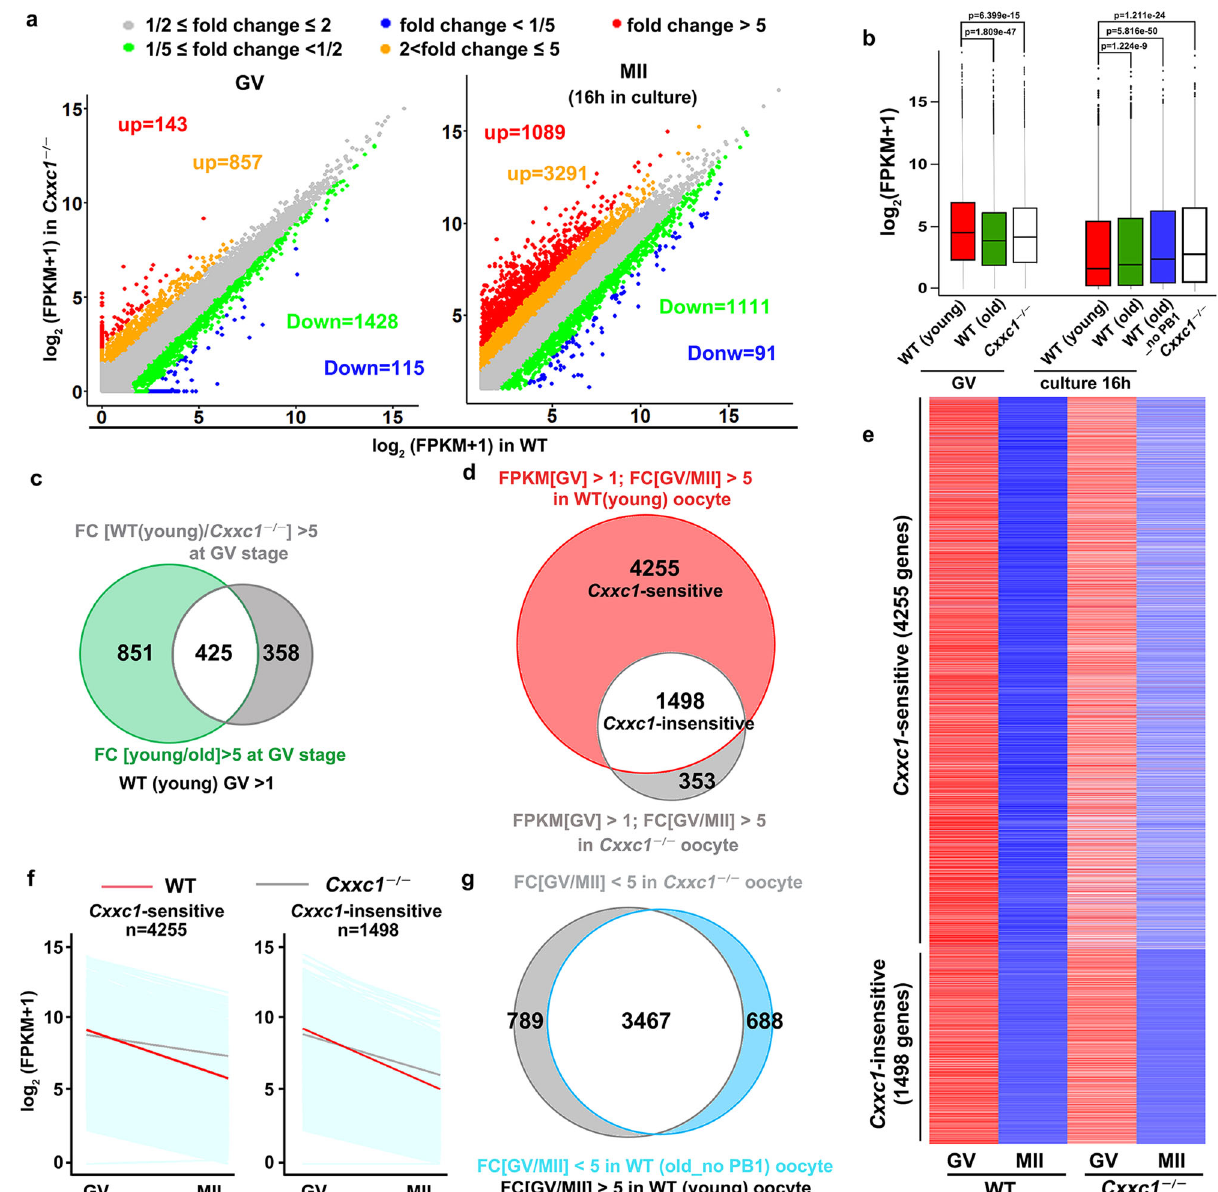
Fig. 6 Meiotic maturation-coupled mRNA decay in Cxxc1 -deleted oocytes. a Scatter plots of RNA-seq data illustrating transcriptional changes in Cxxc1 - deleted oocytes in the GV and metaphase II (MII) stages. b Box plot showing gene expression levels of WT (4-week and 14-month) and Cxxc1 -deleted (4- week) oocytes before and after in vitro maturation culture. N = 3 biologically independent samples were included in young and old WT GV group, Cxxc1 - deleted GV group, old WT MII (with PB1) group and Cxxc1 -deleted MII group. n = 2 biologically independent samples were included in WT old MII (without PB1) group. The box indicates the upper and lower quantiles, the thick line in the box indicates the median, and the whiskers represent the 2.5th and 97.5th percentiles. The dots outside the whiskers of the box plot represent the outliers. P-values by a two-tailed Student ’ s t -test are indicated. c Venn diagram showing the overlap of transcripts that decreased more than 5 fold in WT (14-months) and Cxxc1 -deleted oocytes (4-week) compared with WT (4-week) oocytes at the GV stage. d Venn diagram showing the overlap of transcripts that decreased 5 fold from the GV to MII stage in 4 week WT and Cxxc1 - deleted oocytes. Transcripts with FPKM > 1 at the GV stage were selected and analyzed. e Heat maps showing level changes in maternal transcripts removed during oocyte meiotic maturation in a Cxxc1 -dependent and independent manner. f Degradation patterns of mouse maternal transcripts during GV-MII transition in oocytes derived from 4-week-old WT and Cxxc1 oo – / – mice. Each light blue line represents the expression level of one gene, and the middle red and gray lines represent the median expression levels of the cluster. g Venn diagram showing the overlap of M-decay transcripts that were stabilized during in vitro maturation in 14 month WT (no PB) and 4-week Cxxc1 -deleted